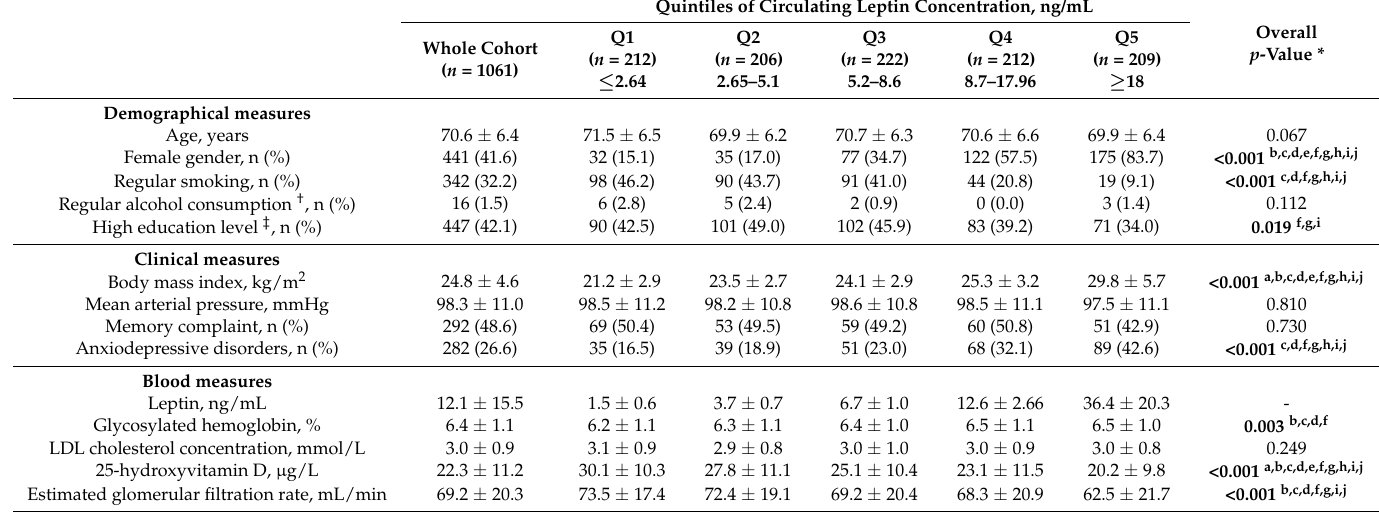
Table 1. Participant data.